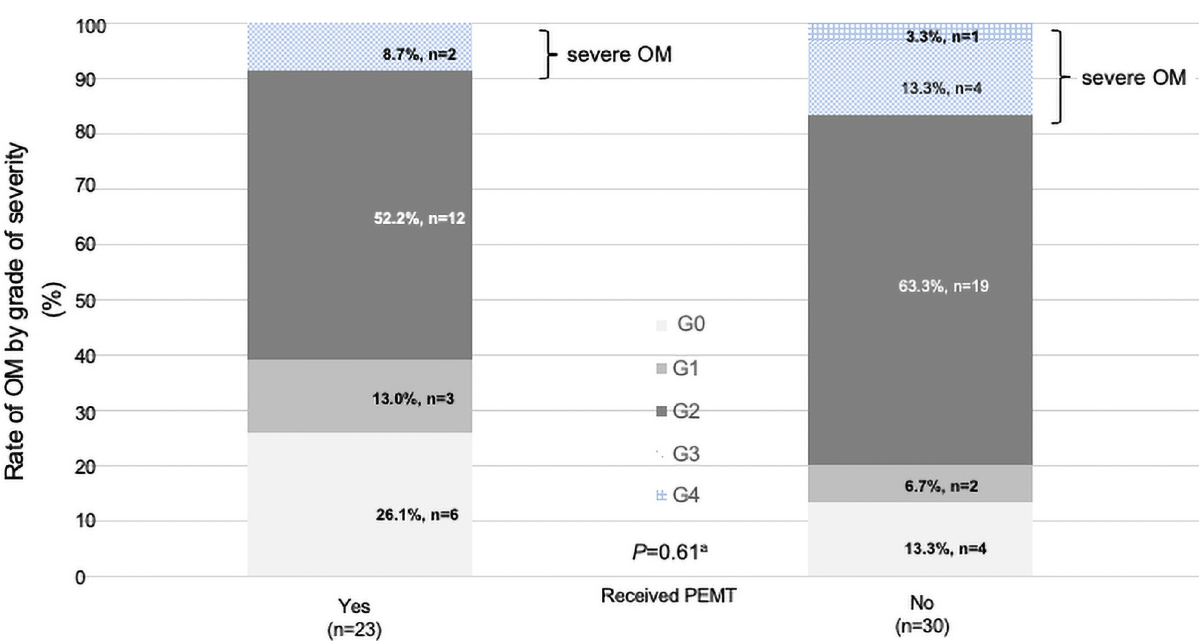
Fig 2. Severity of oral mucositis by CTCAE grade. CTCAE = Common terminology criteria for adverse events. a Fisher’s exact test.